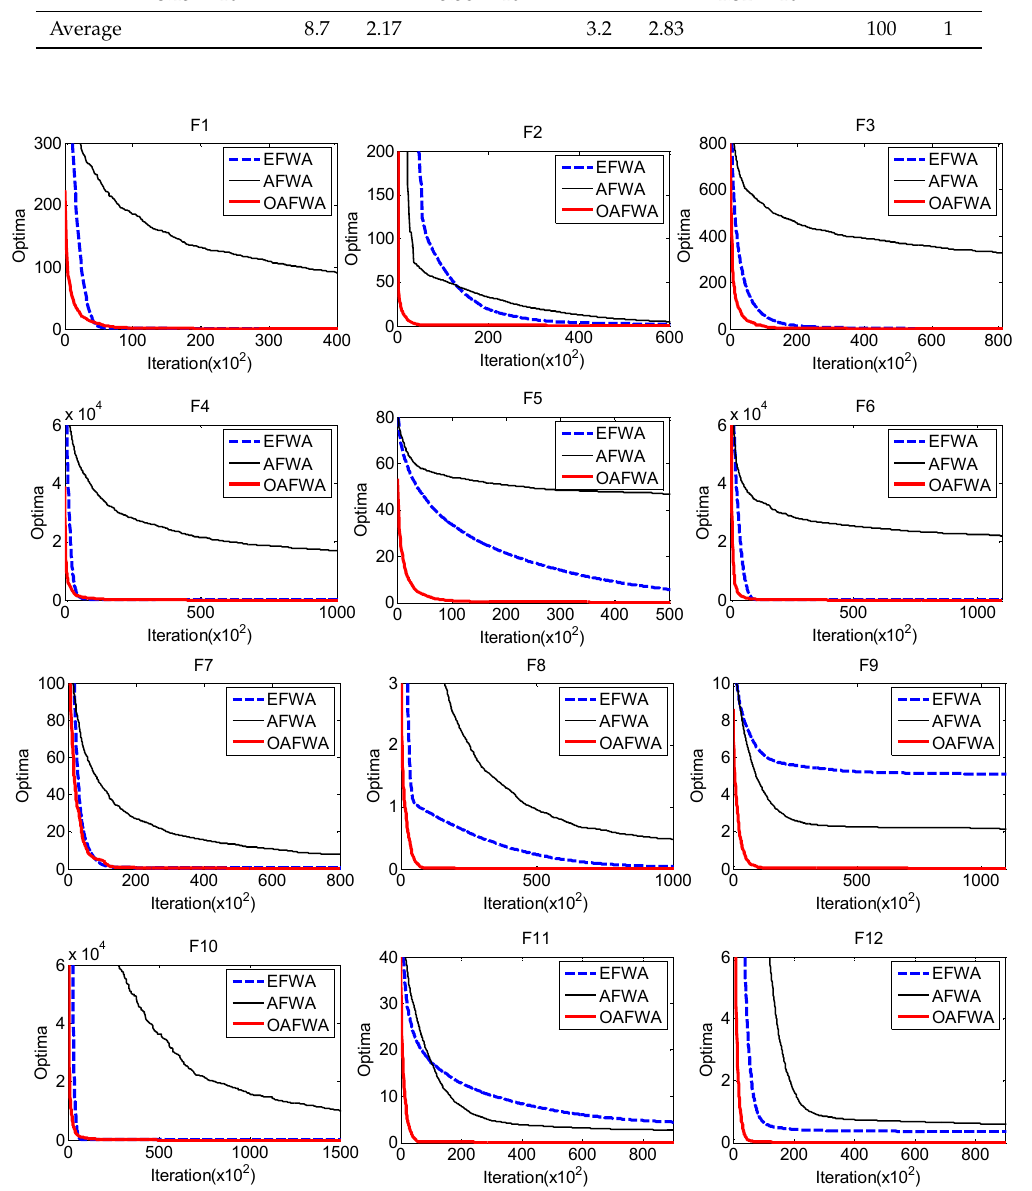
Figure 2. The EFWA, AFWA, and OAFWA searching curves.